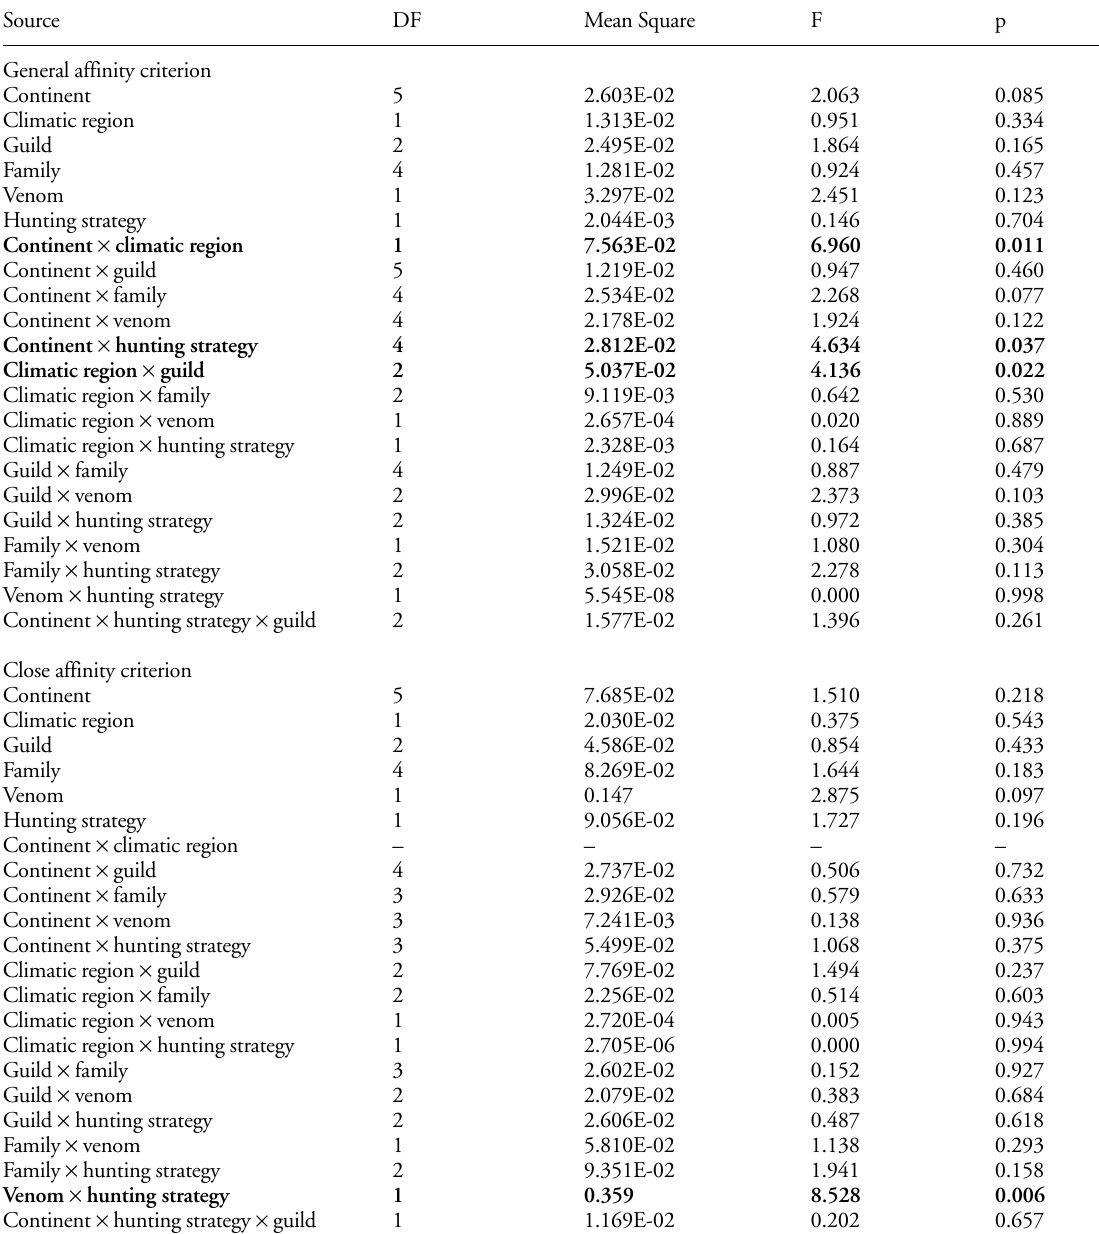
Table 3. Comparative results of the effects of the various variables on the interpopulation diet overlap. 1-way ANOVAs were used for measuring the effects of single factors, and GLM – general factorial design for measuring the effects of the interaction terms between independent factors. Effects with significant values are in